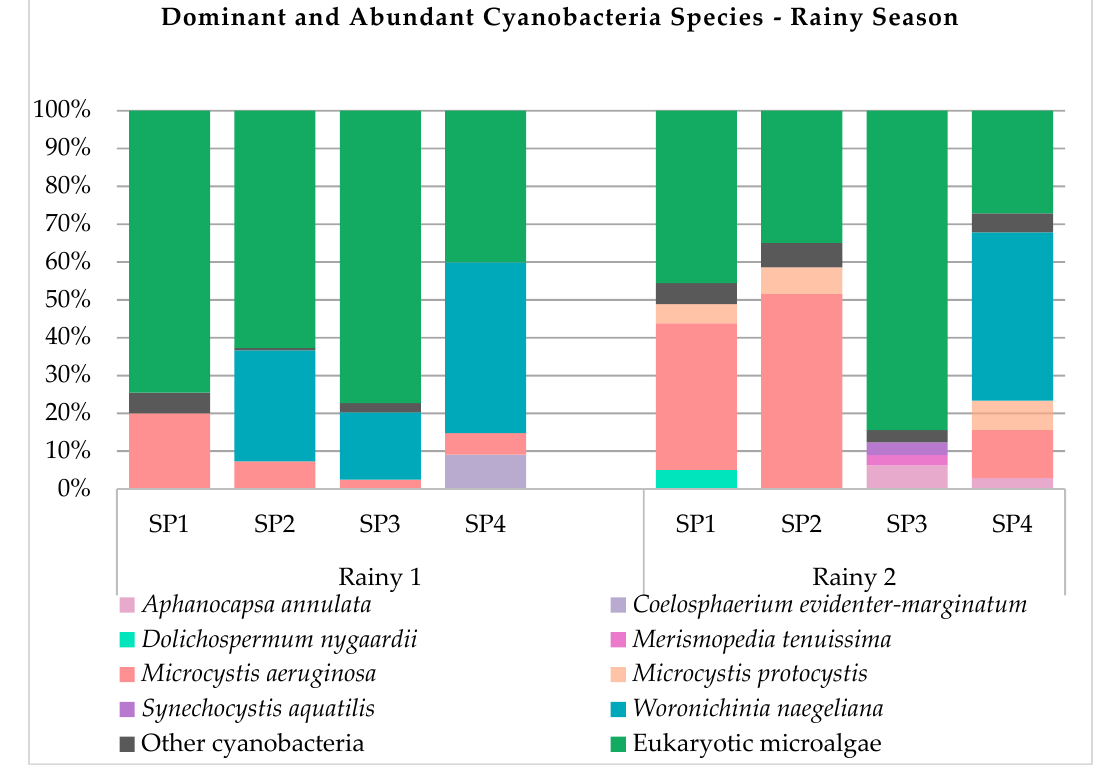
Figure 2. Dominant and abundant cyanobacteria species. Water 2019 , 11 , x FOR PEER REVIEW